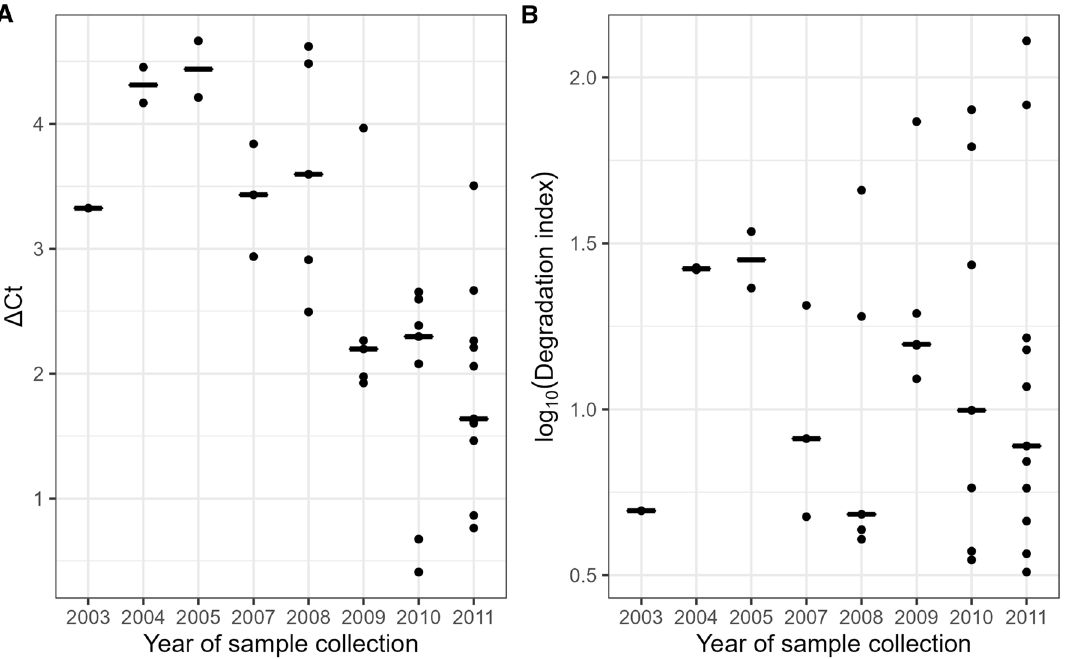
Figure 3. Dot plots of qualitative measurements and storage time, vertical bar indicates median value. ( A ) Infinium QC ΔCt (r 2 = 0.50; p < 10 −5 ). ( B ) QuantifilerTrio DI (r 2 < 0.01; p > 0.05).